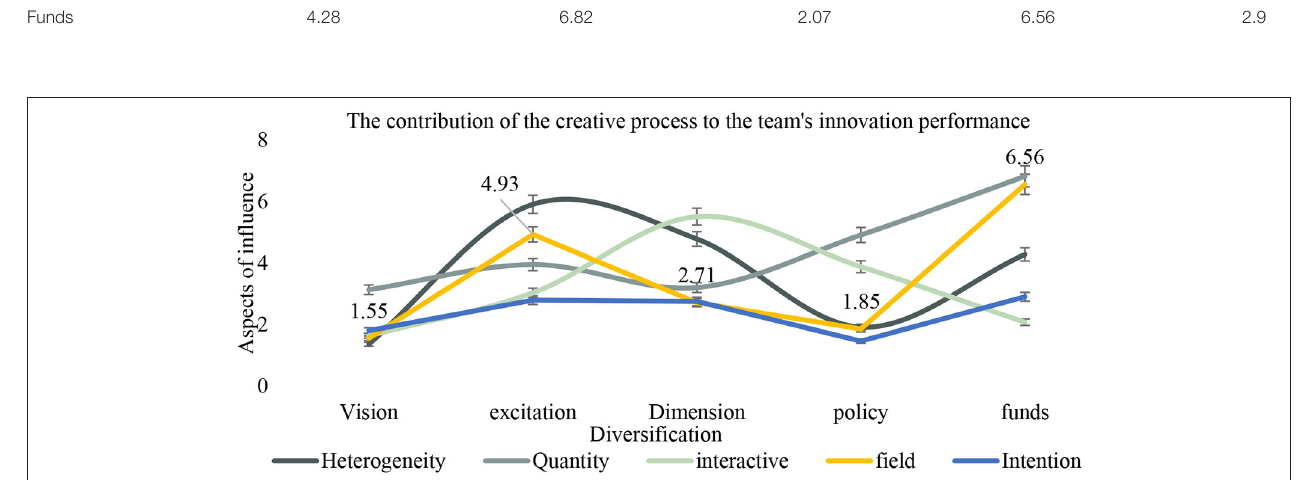
FIGURE 11 | The contribution of the creative process to the team’s innovation performance.